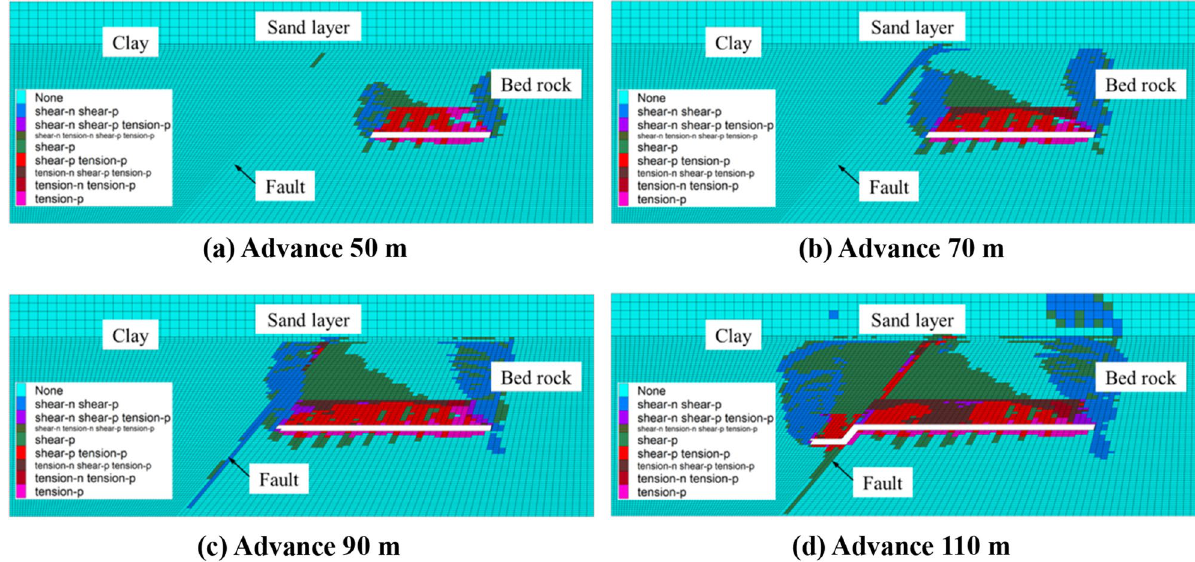
Figure 5. Plastic failure diagram of the model for a bedrock thickness of 30 m.